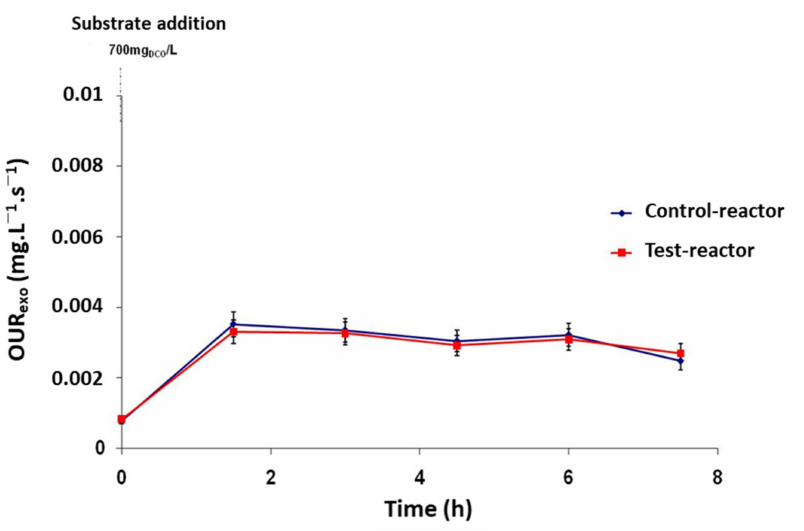
Figure 4. Evolution of the oxygen uptake rate (OUR) in exogenous conditions as a function of time in the test reactor and in the control